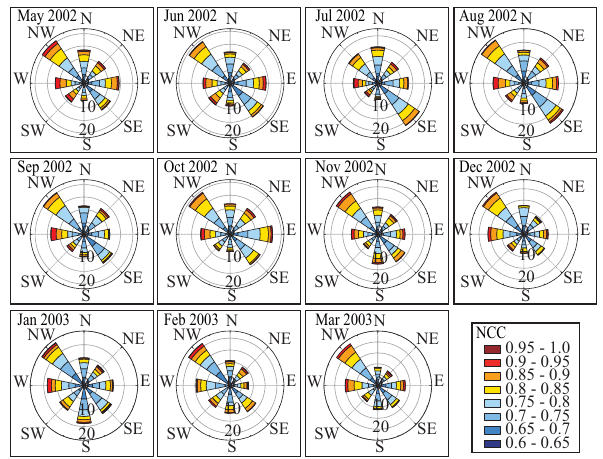
Fig. 6. The direction and NCC distribution of high NCC( > 0.6) fil- tering results. The direction of the windrose indicates the evaluated direction calculated by the modified correlation product, and the ve- locity of the windrose suggests the magnitude of